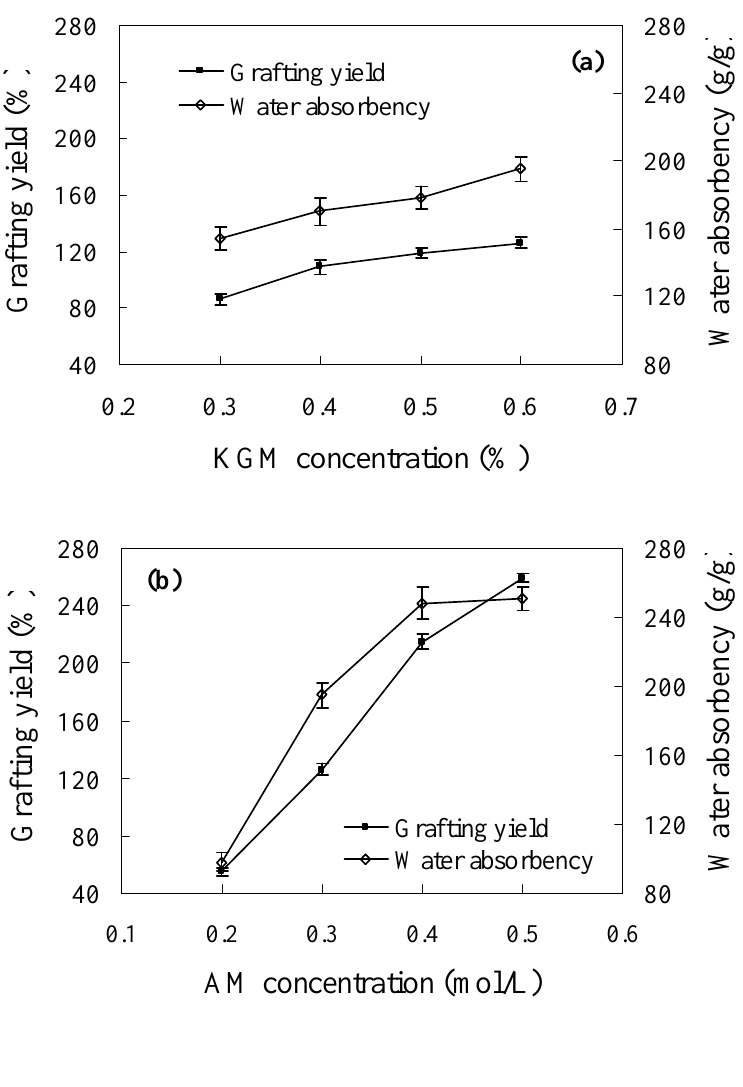
Figure 3. Effects of (a) KGM concentration; grating condition: dosage =0.8 kGy, [AM] = 0.3 mol/L) and (b), AM concentration; grafting condition: dosage = 0.8 kGy, [KGM] = 0.6%) on grafting yield and water absorbency of